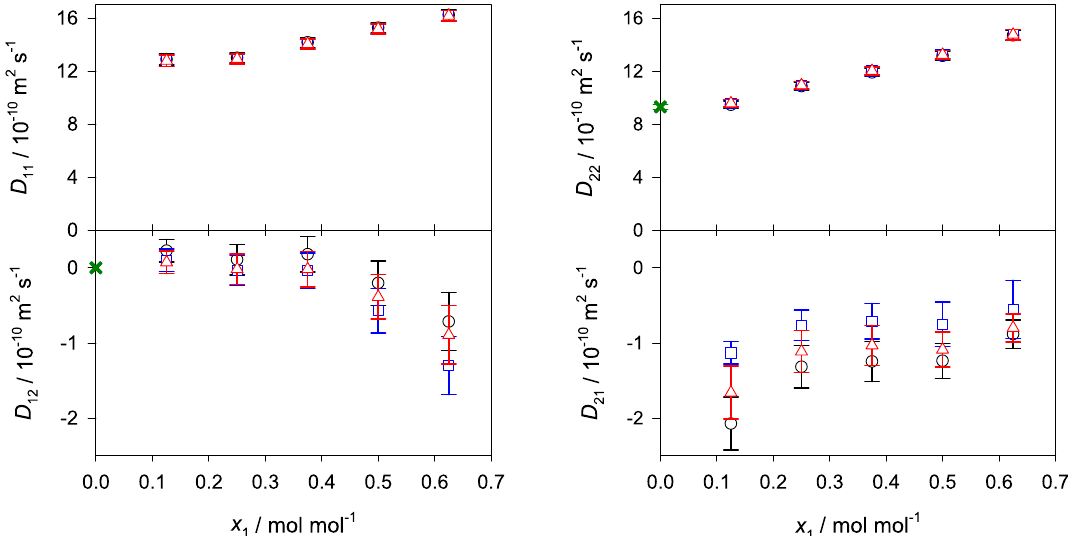
Figure 4. Elements of the Fick diffusion coefficient matrix in the molar (black circles), volume (blue squares) and mass reference frame (red triangles) of the ternary subsystem methanol (1) + ethanol (2) + 2-propanol (3) 1 with x 3 = 0.25 molmol − at 298.15 K and 0.1 MPa. The green crosses represent the expected values in the binary limit x 1 → 0 for the molar reference frame.